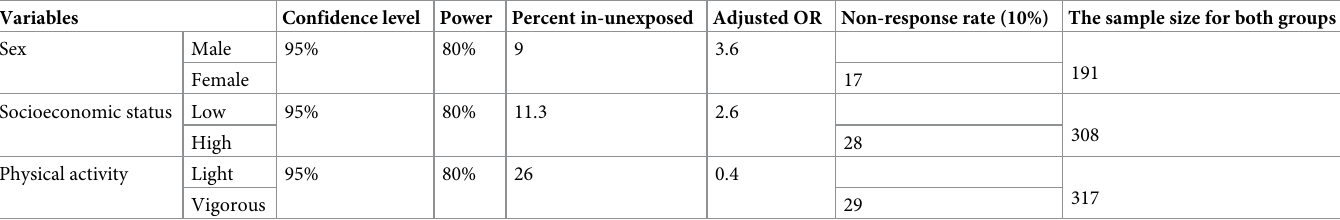
Table 1. Sample size determination for the second objective in Welkite town, Southern Ethiopia, 2020.